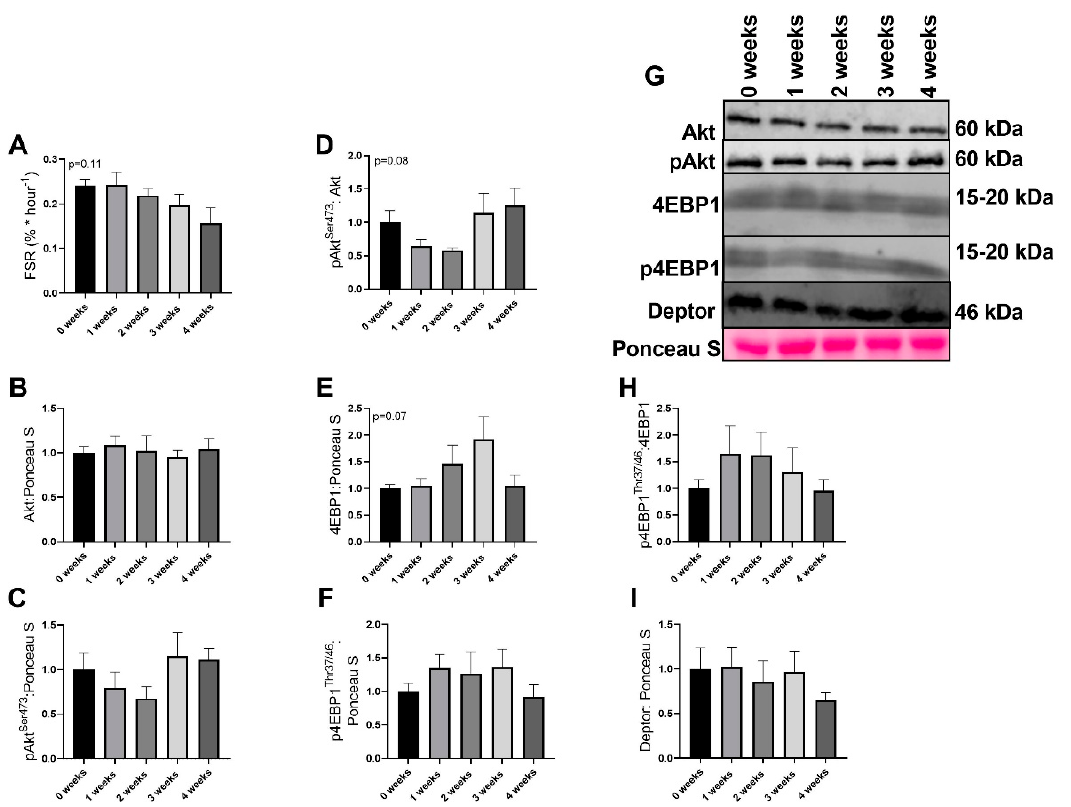
Figure 3. Markers of protein anabolism in the diaphragm. ( A ) Fractional synthesis rate (FSR) ( B ) Akt protein content ( C ) pAkt Ser473 protein content. ( D ) pAkt Ser473 / Akt protein content. ( E ) 4EBP1 protein content ( F ) p4EBP1 Thr37 / 46 protein content. ( G ) Representative images for immunoblot data ( H ) p4EBP1 Thr37 / 46 / 4EBP1 protein content. ( I ) Deptor protein content. Data are presented as mean ± SEM. n = 8–10/group.